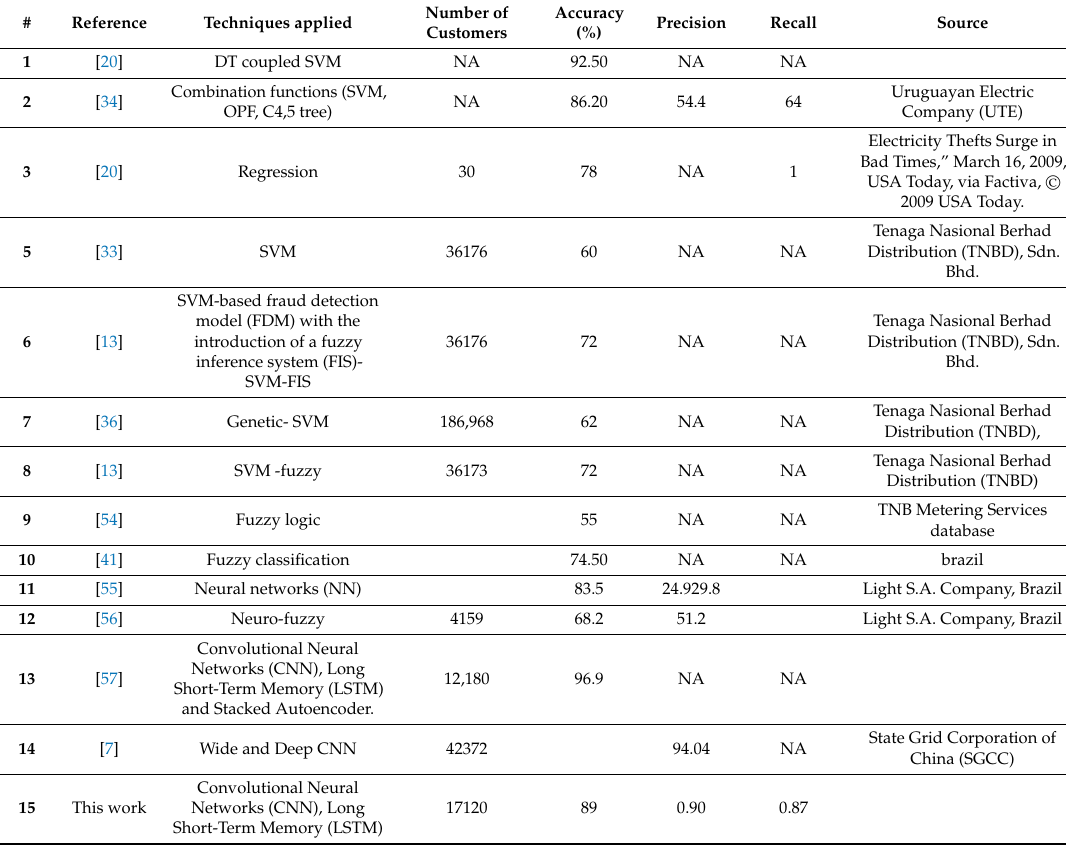
Table 4. Summary of models, data sets and performance